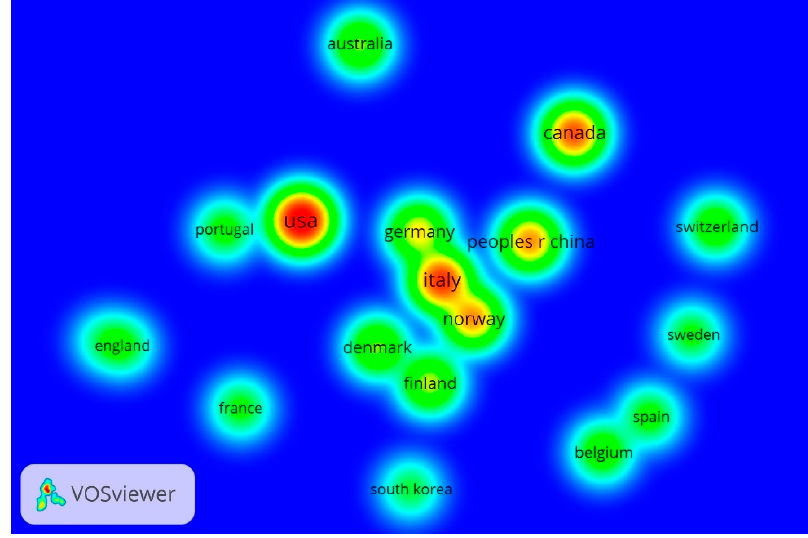
Figure 7. Citation map representing influential countries (net zero).